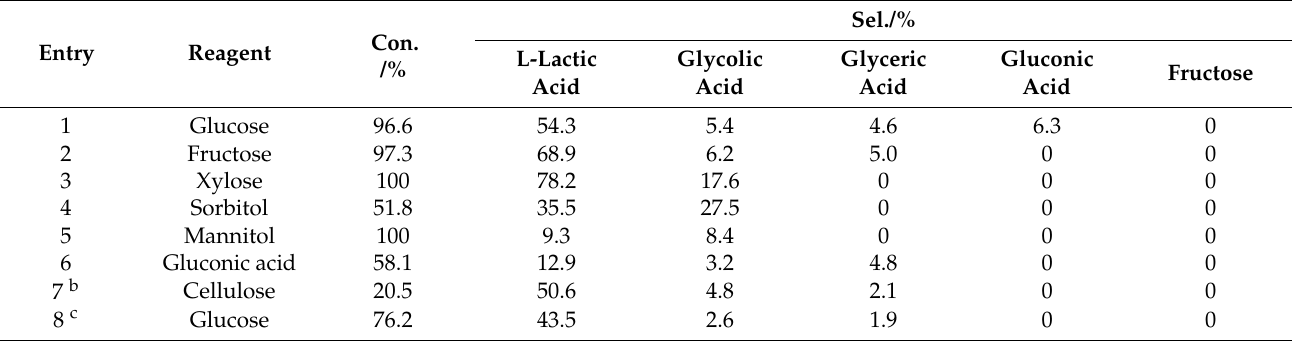
Table 4. Catalytic performance of RuO x /MoS 2 catalyst in the presence of CaO with different feed- stocks a